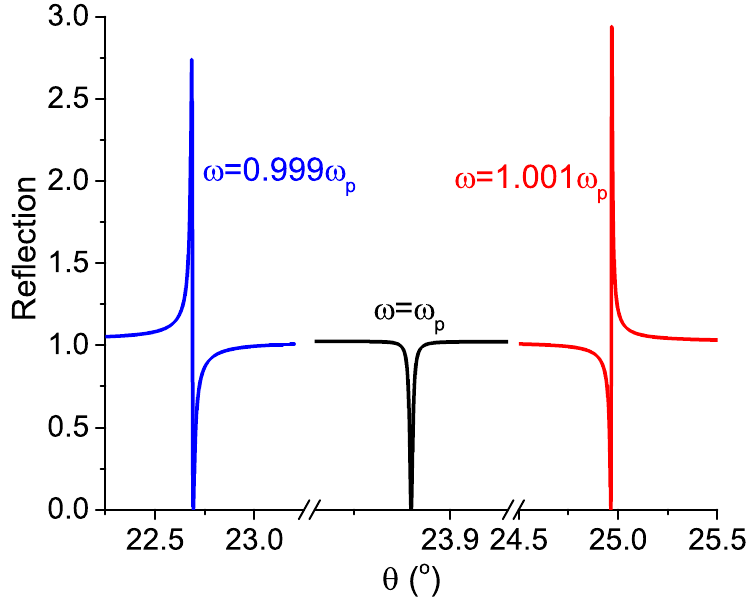
Figure 2. Dependence of reflection on the incidence angle for three different frequencies. The non- Hermiticity parameter is γ = 10 − 3